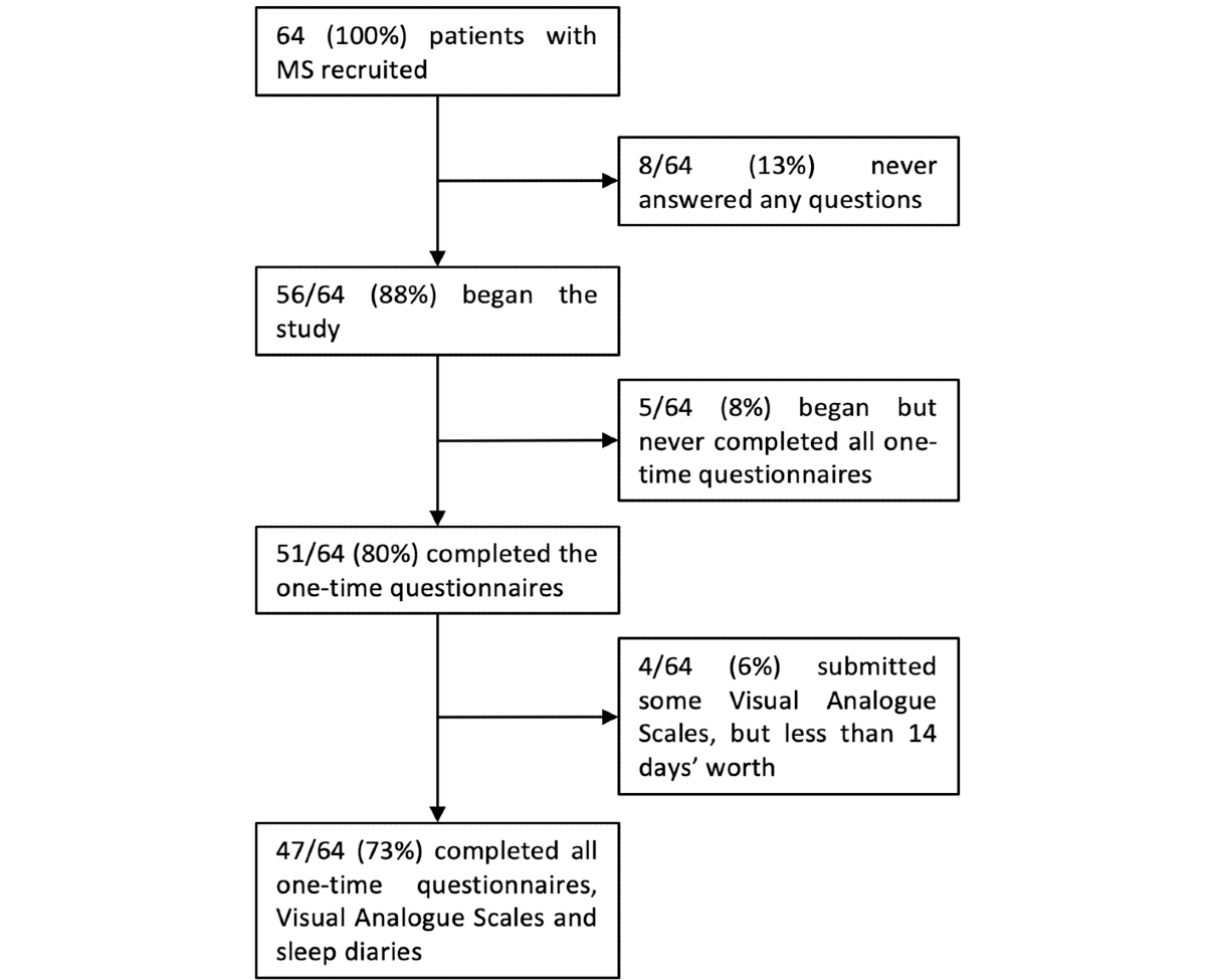
Figure 5. Patient compliance in our study cohort. MS: multiple